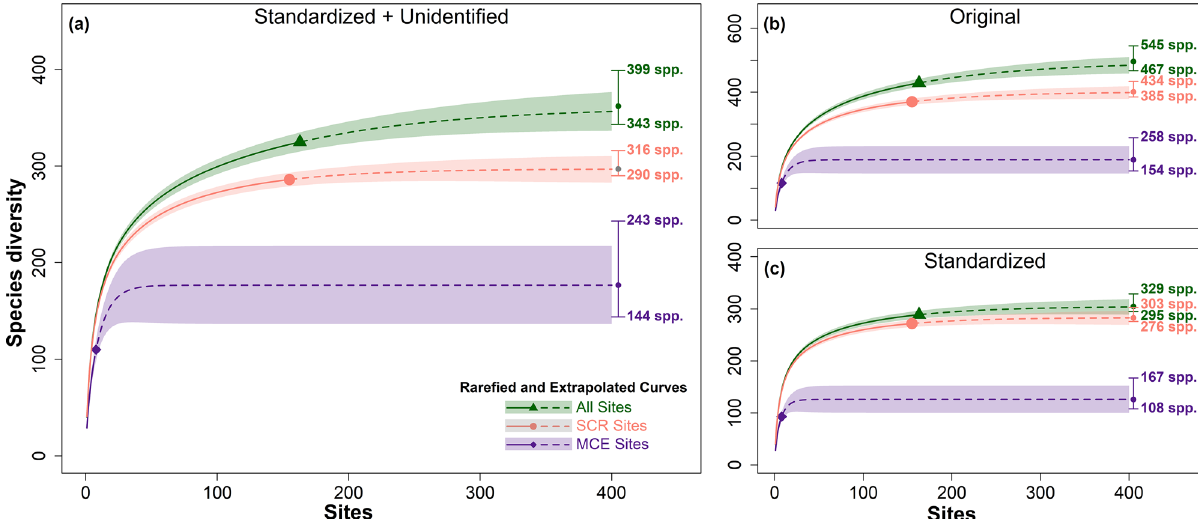
Figure 2. Species accumulations curves showing MCE, SCR, and all sites under three different methods of reported taxonomic names and species identifications. Solid line indicates the rarefied curve, dashed line indicates the extrapolated curve, symbol indicates the observed species richness, the colored area indicates the 95% confidence interval, and the numbers show the asymptotic diversity estimate. ( a ) Species identification standardized by consolidating the synonymies and using the unidentified species as reported (standardized + unidentified), ( b ) original species identification without consolidating synonymies as well as using the unidentified species as reported (original), and ( c ) species identification standardized by consolidating the synonymies as well as consolidating the unidentified species to a standardized to Genus sp. notation